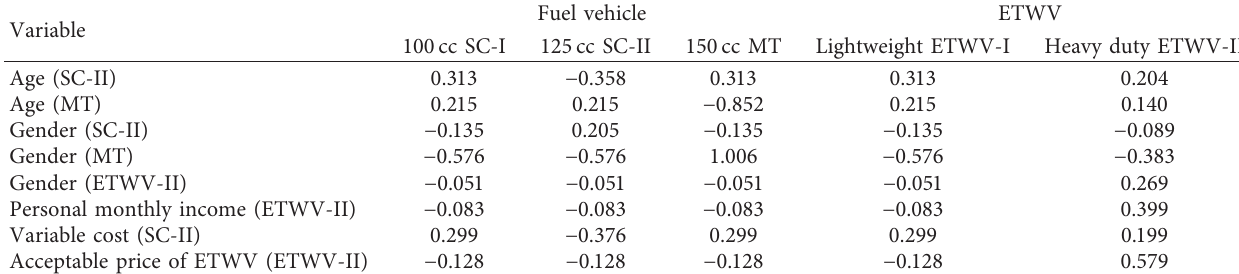
Table 8: Elasticity analysis of socioeconomic and vehicle use characteristics.